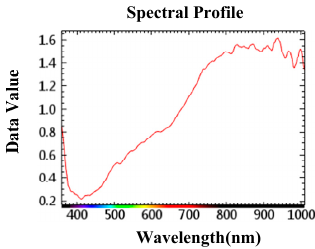
Figure 5. Spectral data of soybean processed by SG filtering.